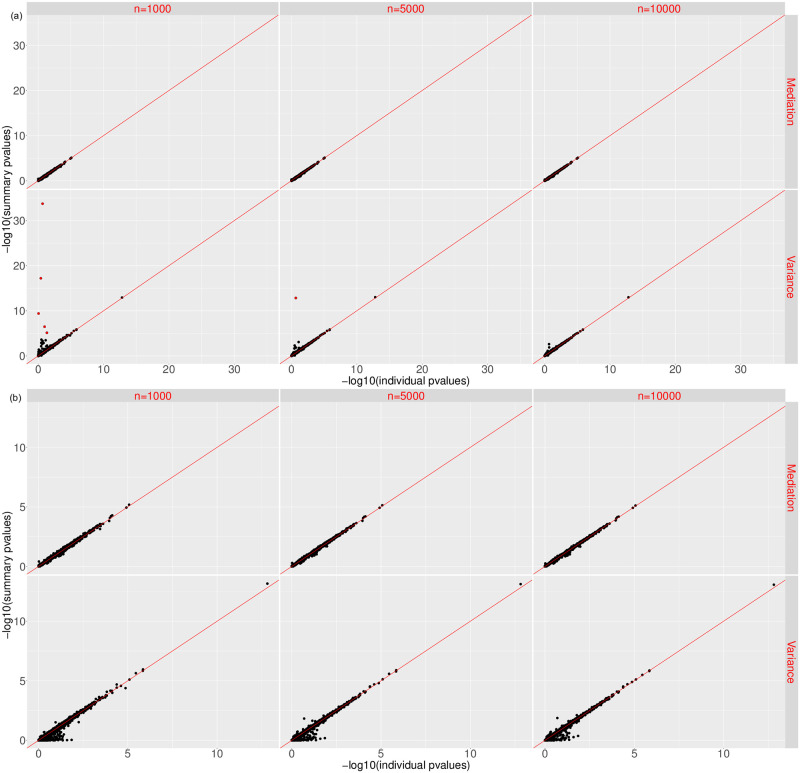
Effect of sample sizes in calculating the genotype covariance matrix on the mediation and variance component p-values for sMiST without regularization (top panel) and with regularization (bottom panel).